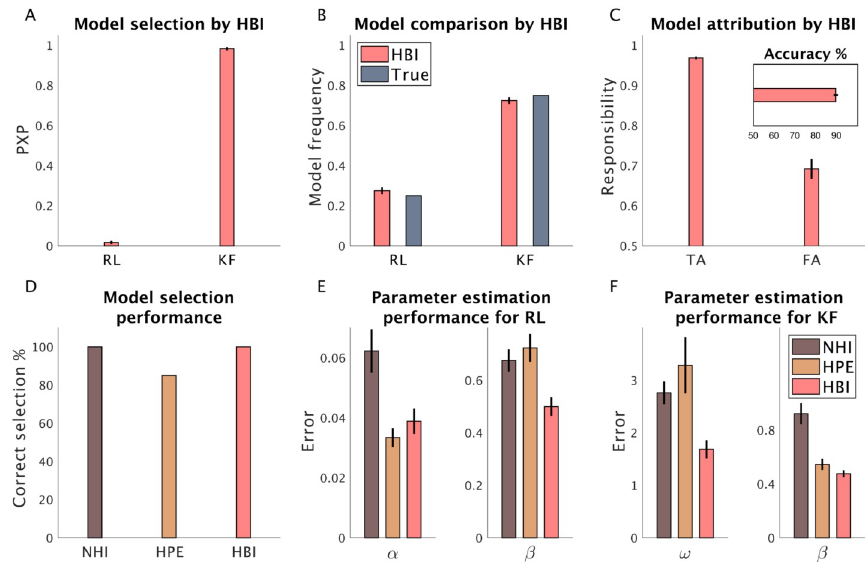
Fig 1. Performance of the HBI in a synthetic dataset. 10 and 30 artificial subjects were generated according to the RL (RL) and Kalman filter (KF) models, respectively. A) Model selection by HBI using protected exceedance probabilities (PXP); B) Model frequencies estimated by the HBI. C) Model attribution at the individual level by the HBI; Responsibility estimates are plotted for true attributions (TA), in which the true model has been attributed, and for false attributions (FA), in which the incorrect model is attributed. The HBI shows lower levels of responsibility for FA. Inset: percentage of correct assignment of the model by the HBI at the individual level. D) Comparison of accuracy of model selection with HPE and NHI; E, F) Error in estimating individual parameters of the RL (E) and the Kalman filter model (F). The estimation error is defined as the absolute difference between estimated parameters and the true parameters. In all plots, error-bars are standard errors of the mean obtained across 20